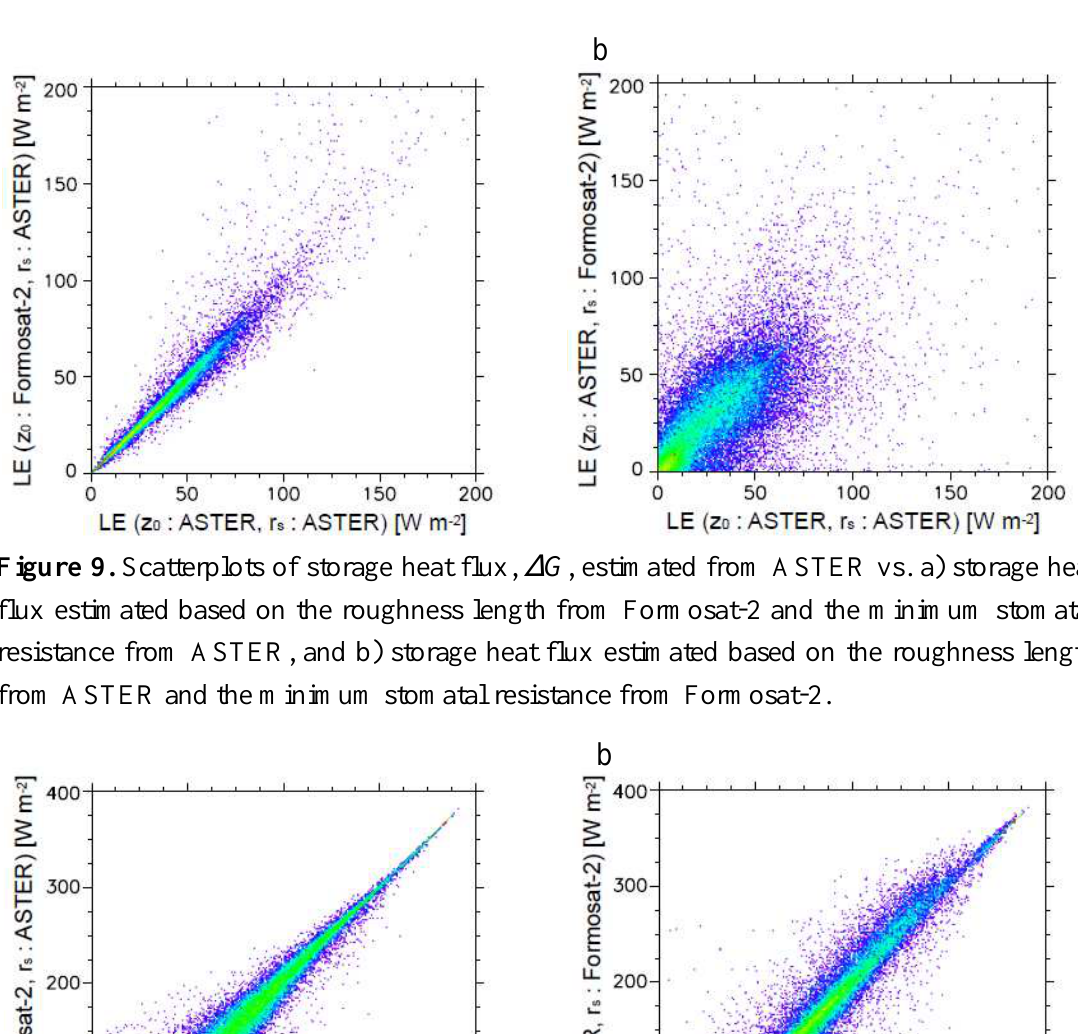
Figure 8. Scatterplots of latent heat flux, LE , estimated from ASTER vs. a) latent heat flux estimated based on the roughness length from Formosat-2 and the minimum stomatal resistance from ASTER, and b) latent heat flux estimated based on the roughness length from ASTER and the minimum stomatal resistance from Formosat-2.